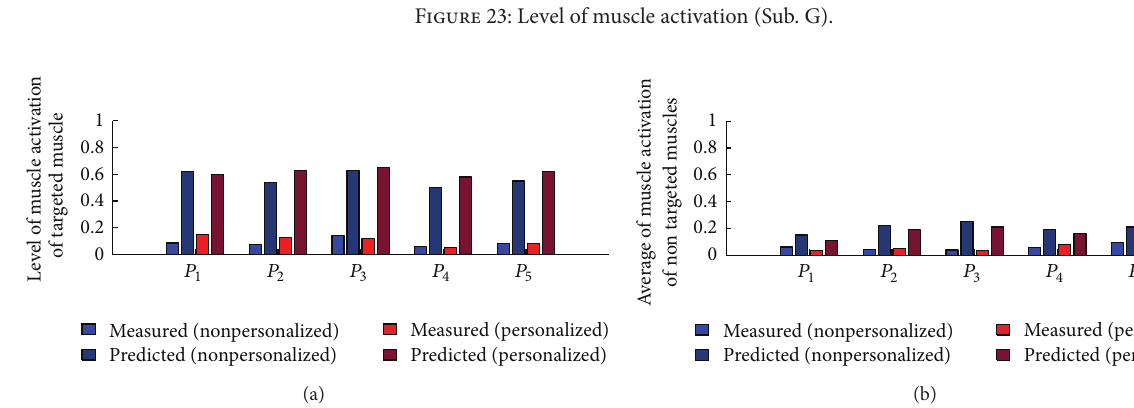
Figure 23: Level of muscle activation (Sub. G).